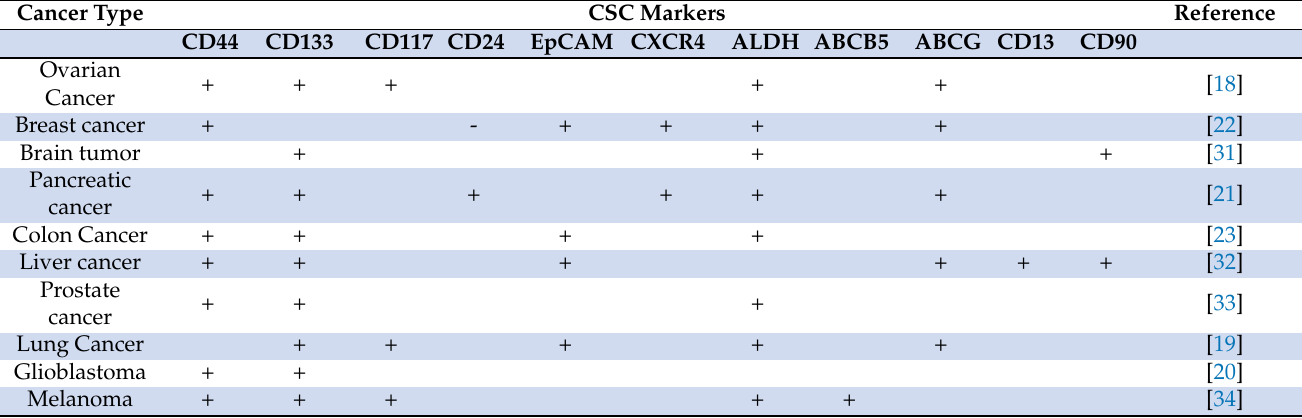
Table 1. CSC markers of the major cancer